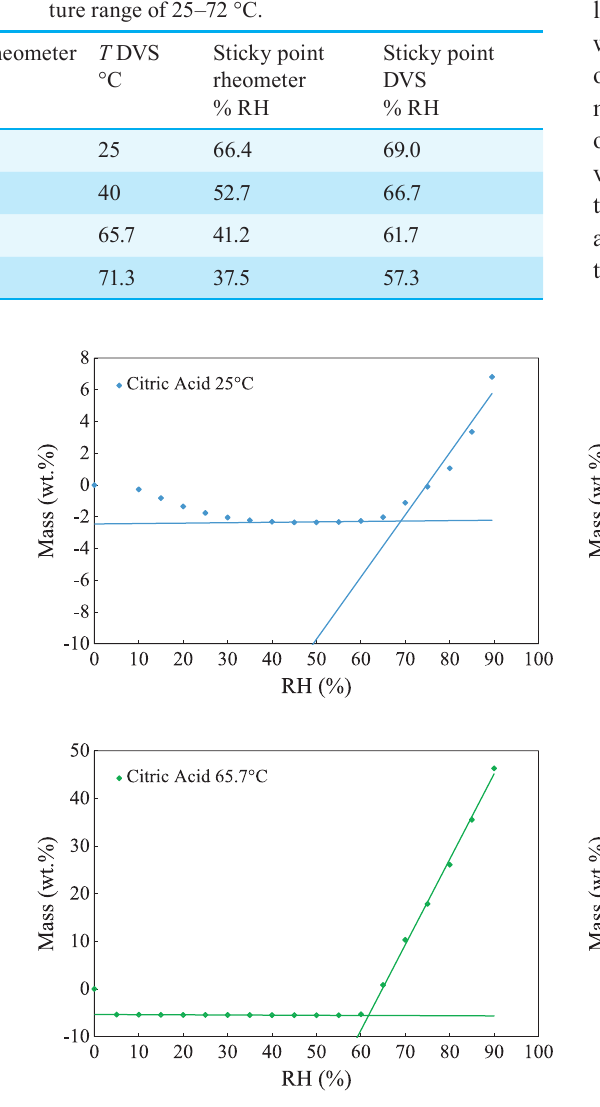
Fig. 7 Water vapor isotherms of the citric acid monohydrate sample at 4 different temperatures, 25 °C, 40 °C, 65.7 °C and 71.3 °C, with the fitted regions in the isotherms obtained with the Dynamic Vapor Sorption technique.